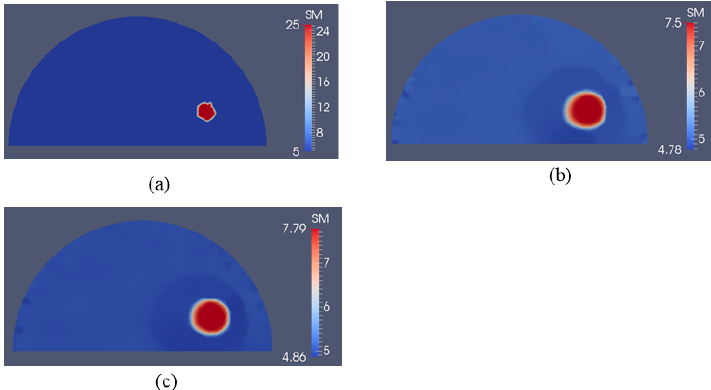
Figure 10. Shear modulus reconstruction with 0.1% noise. ( a ) target shear modulus distribution with a smaller inclusion radius of 0.5 cm is defined to study detectability of the inclusion to its size; ( b , c ) reconstructed shear modulus distribution using 5 and 10 boundary displacement data sets, respectively (unit in the scale bar: kPa). Note: “SM” stands for shear modulus.